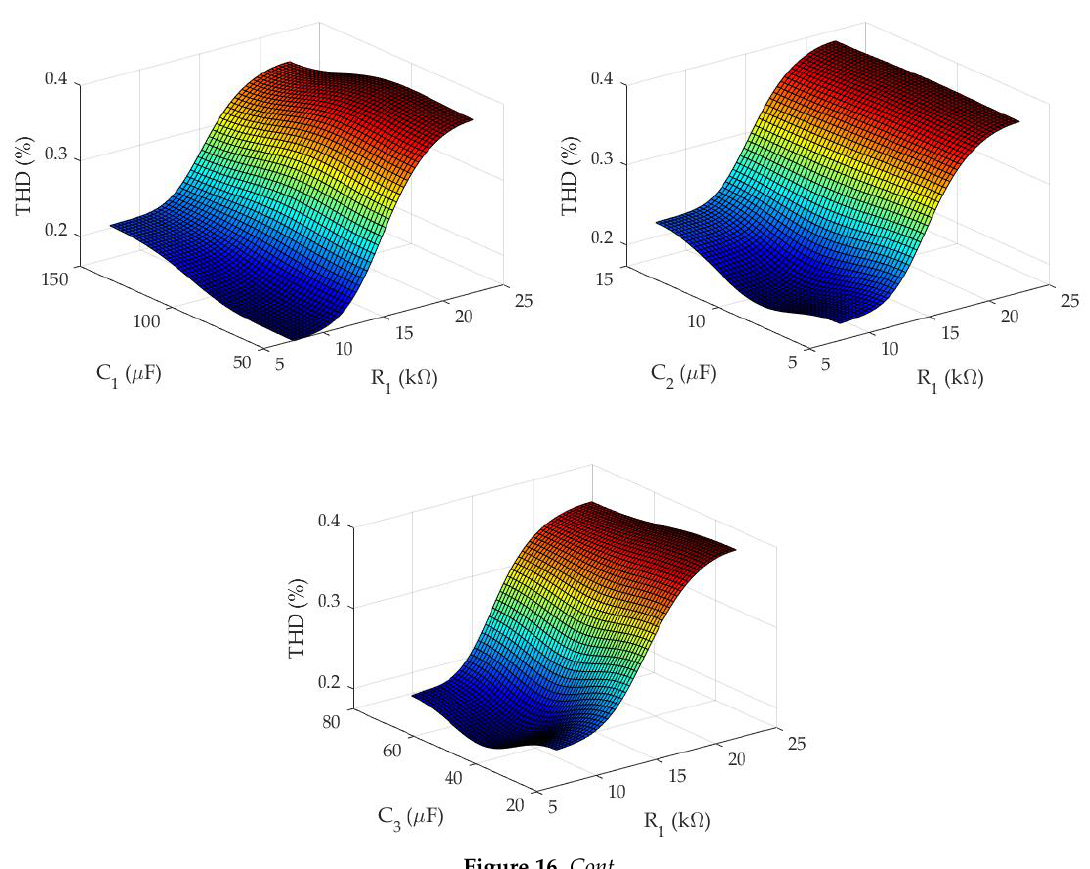
Figure 16. Response surface for THD vs. R 1 and {R 2 , R 3 , R 4 , R 5 , C 1 , C 2 , C 3 }. Figure 16. Cont